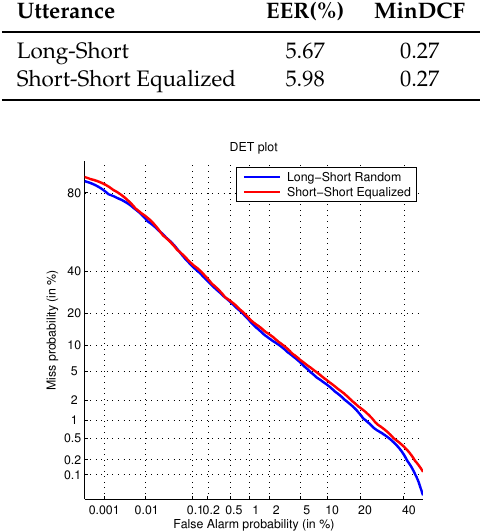
Figure 8. DET curves for the scenarios Long-Short Random and Short-Short Equalized in SRE10 “coreext-coreext det5